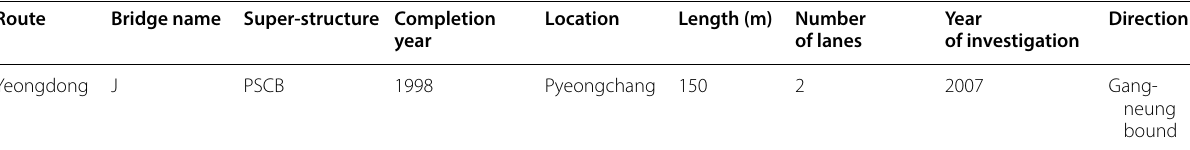
Table 1 Status of the pilot bridge: ‘J’ bridge.